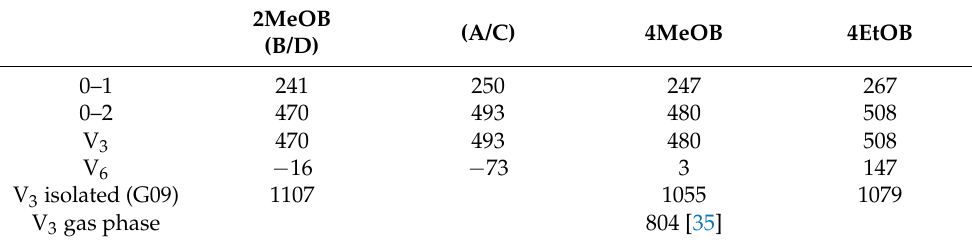
Table 7. Components of the potential energy function for methyl rotation, derived from torsional frequencies. All values are in cm − 1 . 2MeOB (A/C) (B/D)